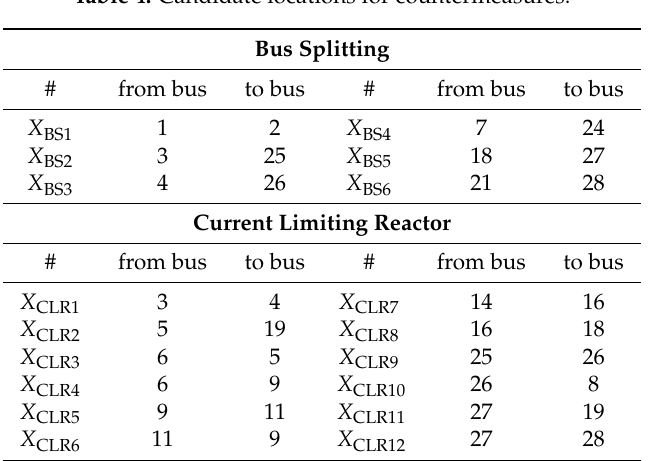
Table 4. Candidate locations for countermeasures.